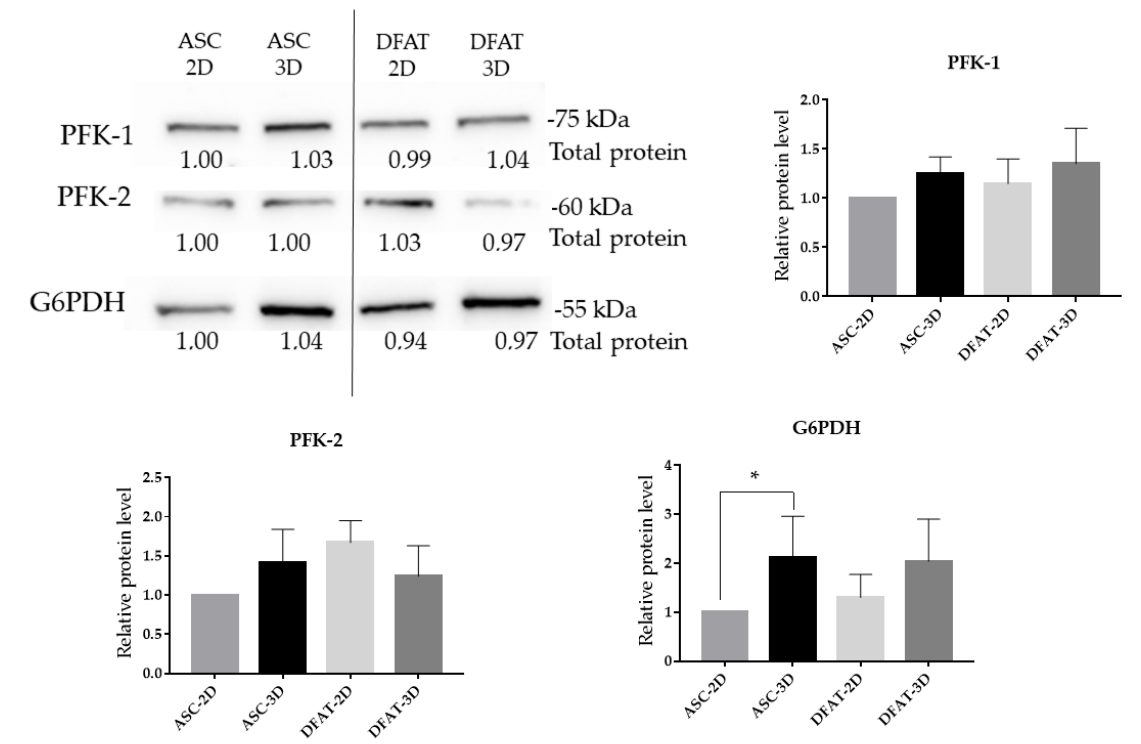
Figure 13. Relative protein levels of enzymes involved in glycolysis. The results are presented as a mean value of 3-4 biological replications and are normalized per µg of protein ± SD, for * p < 0.05.